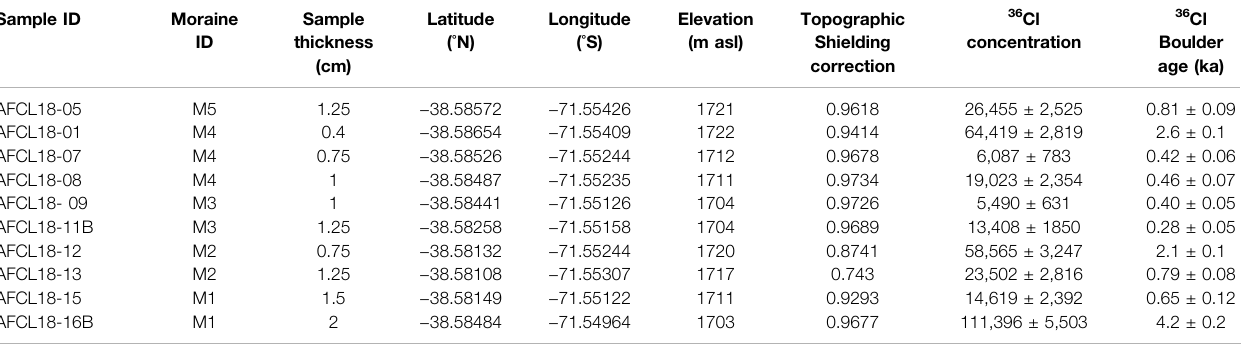
TABLE 2 | Sample information used in the calculation of the 36 Cl boulder age expressed with internal uncertainty, calculated with a rock formation age of 130 ka using a developmental version of the CRONUS-Earth 36 Cl calculator (Balco et al., 2008; http://stoneage.ice-d.org/math/Cl36/v3/v3_Cl36_age_in.html) and LSDn scaling. The ICE-D calibration datasets used can be found at